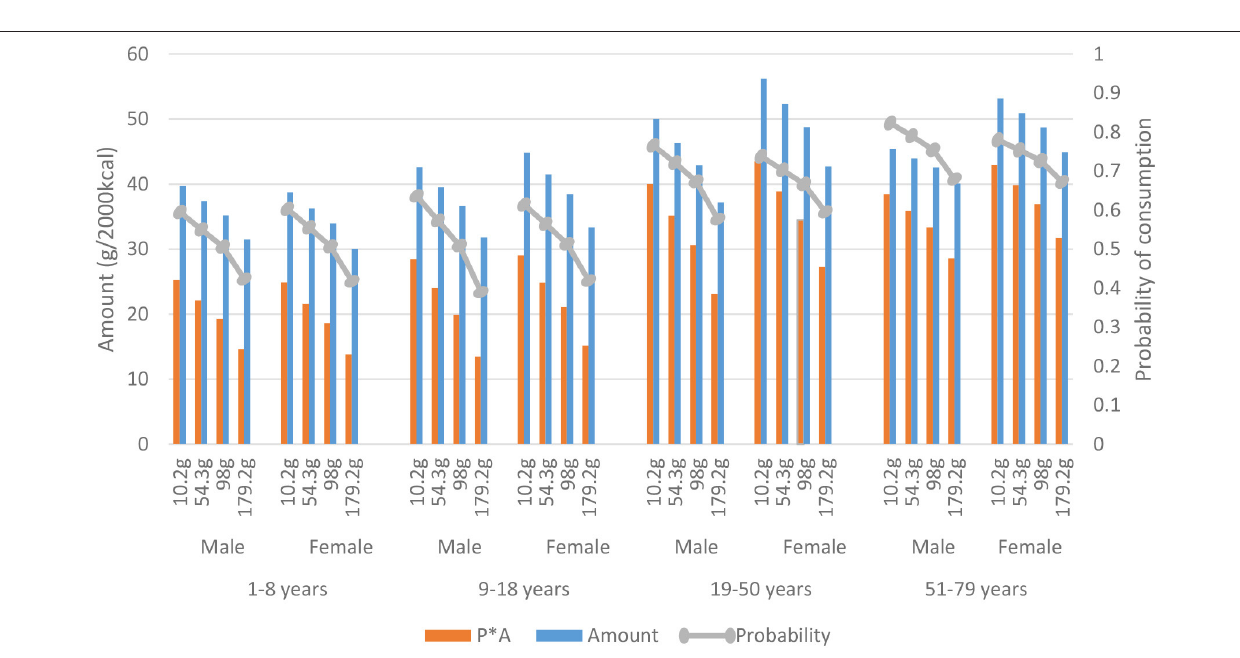
FIGURE 6 | Consumption of cheese presented by mean total meat consumption per quartile, gender, and age. The predicted quantity (P*A) (g/2,000 kcal) is the modeled amount among users (Amount), times the modeled probability of consumption (probability) derived from the Dutch National Food Consumption Survey